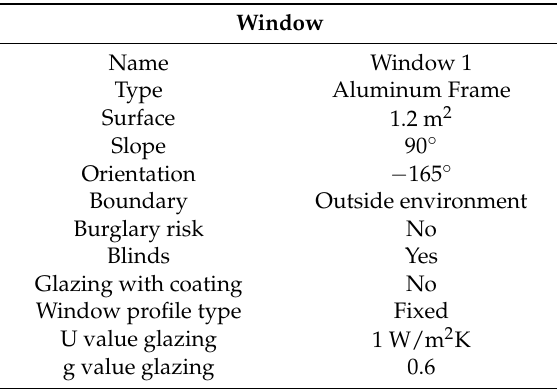
Table 8. Extracted data of one window out of the EPC.